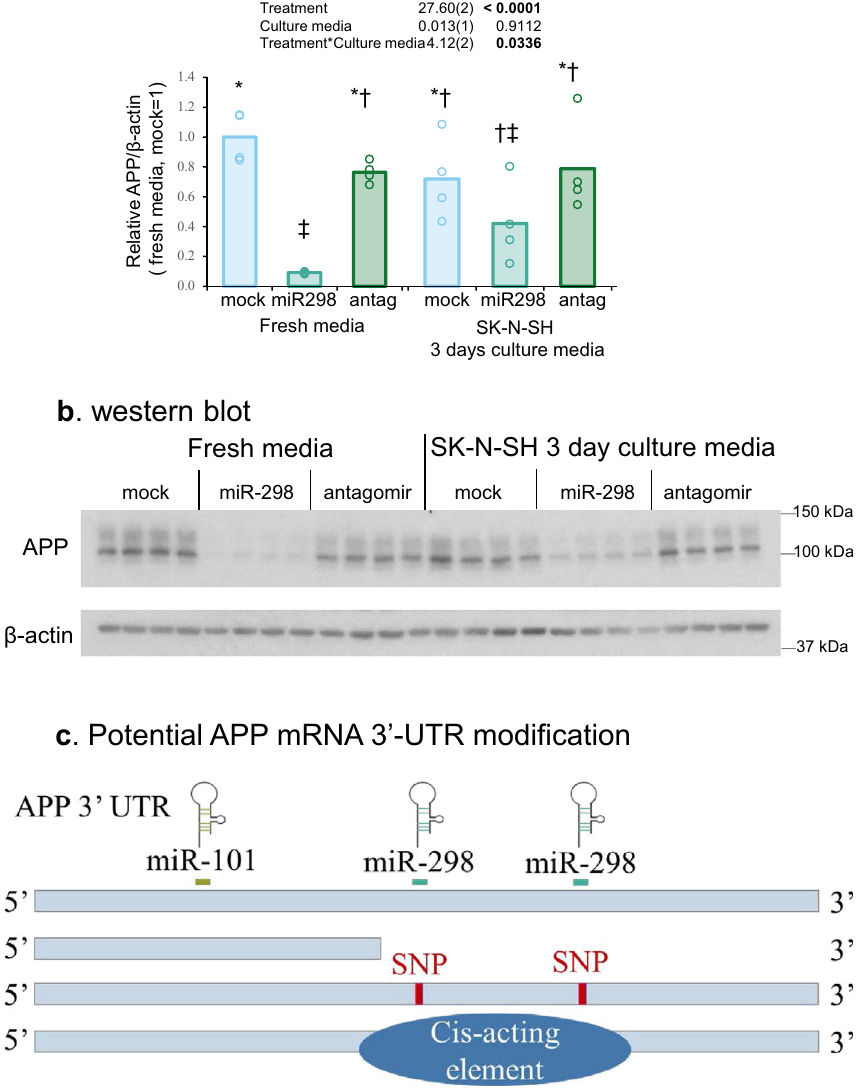
Figure 7. miR-298 treatment’s effect on APP and BACE1 proteins depends on the intrinsic property of each cell type and possible scenarios. ( a ) Western blot of APP and β-actin proteins. ( b ) Densitometry analysis. Each symbol represents a different group. ( c ) Schematic display of potential ways of regulation on APP mRNA 3 ′ -UTR. The miR-298 binding sites on APP 3 ′ -UTR are located downstream of miR-101. Several scenarios that lead to truncated 3 ′ -UTR and could interfere miR-298 binding include alternative polyadenylation sites, presence of SNPs, mutations in miR-298 binding sites and cis-acting elements. Results of pairwise comparison of all treatments is shown by symbols. Treatments sharing a symbol did not significantly differ (p < 0.05). "(ns)" indicates no significant pairwise